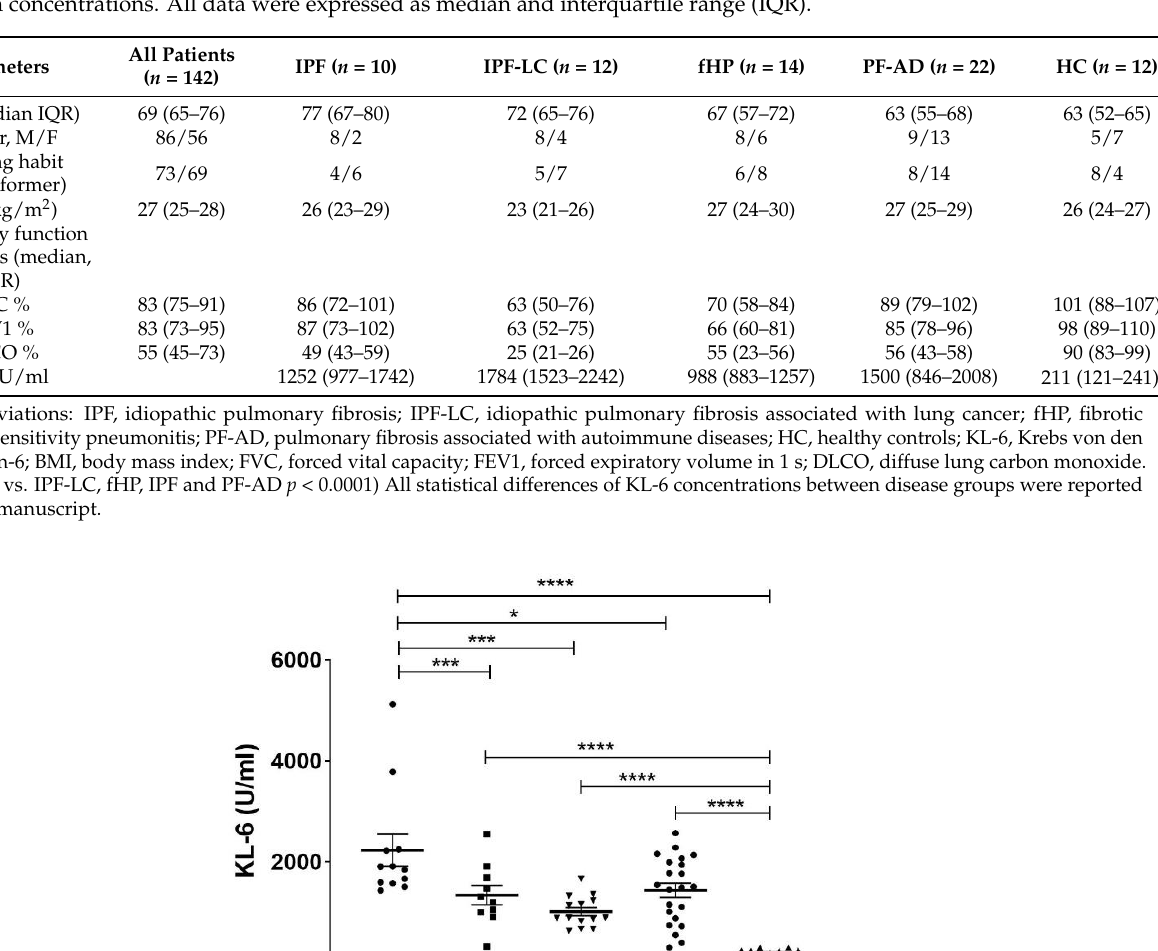
Table 1. Main characteristics of our study population including age, gender, smoking habit, BMI, LFT parameters, and KL-6 serum concentrations. All data were expressed as median and interquartile range (IQR).